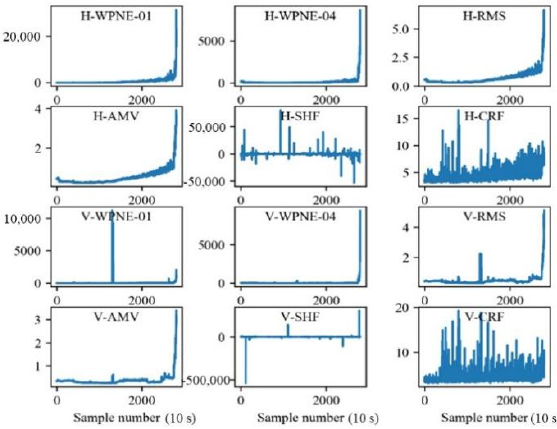
Figure 5. Some alternative features of Bearing1_1.